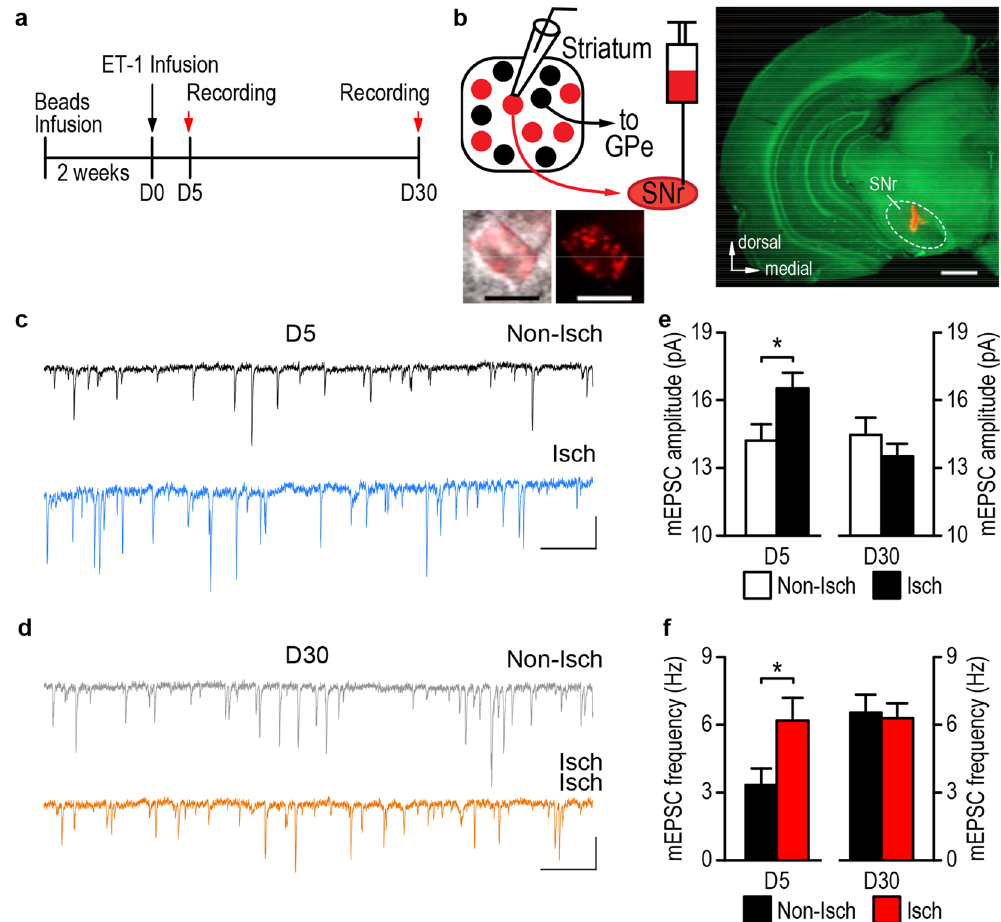
Figure 4. Stroke enhances glutamatergic drive of DMS D1-MSNs in alcohol-drinking rats. ( a ) Schematic illustration of the experimental procedure. ( b ) Retrograde labeling of D1-MSNs. Left top, diagram showing that retrograde beads infused into the SNr labeled DMS D1-MSNs. Right, representative image depicting the infusion site in the SNr. Scale bar: 1 mm. Left bottom, sample image of bead-labeled D1-MSNs. Scale bar: 10 µ m. ( c and d ) Representative mEPSC traces from the non-ischemic (Non-Isch) and ischemic (Isch) sides on day 5 (D5, c ) and day 30 (D30, d ). Scale bars: 0.5 s, 10 pA. ( e ) Bar graphs showing an increased mEPSC amplitude on the Isch side, as compared to the Non-Isch side on D5 (left), and no differences between the two groups on D30 (right). * p < 0.05 by t test. D5: n = 11 (Non-Isch) and 17 (Isch) neurons from 7 rats per group; D30: n = 13 (Non-Isch) and 11 (Isch) neurons from 7 rats per group. ( f ) Bar graphs depicting an increase in mEPSC frequency on the Isch side, as compared to the Non-Isch side on D5 (left), and no differences between these two groups on D30 (right). * p < 0.05 by t test. D5: n = 11 (Non-Isch) and 17 (Isch) neurons from 7 rats per group; D30: n = 13 (Non-Isch) and 11 (Isch) neurons from 7 rats per